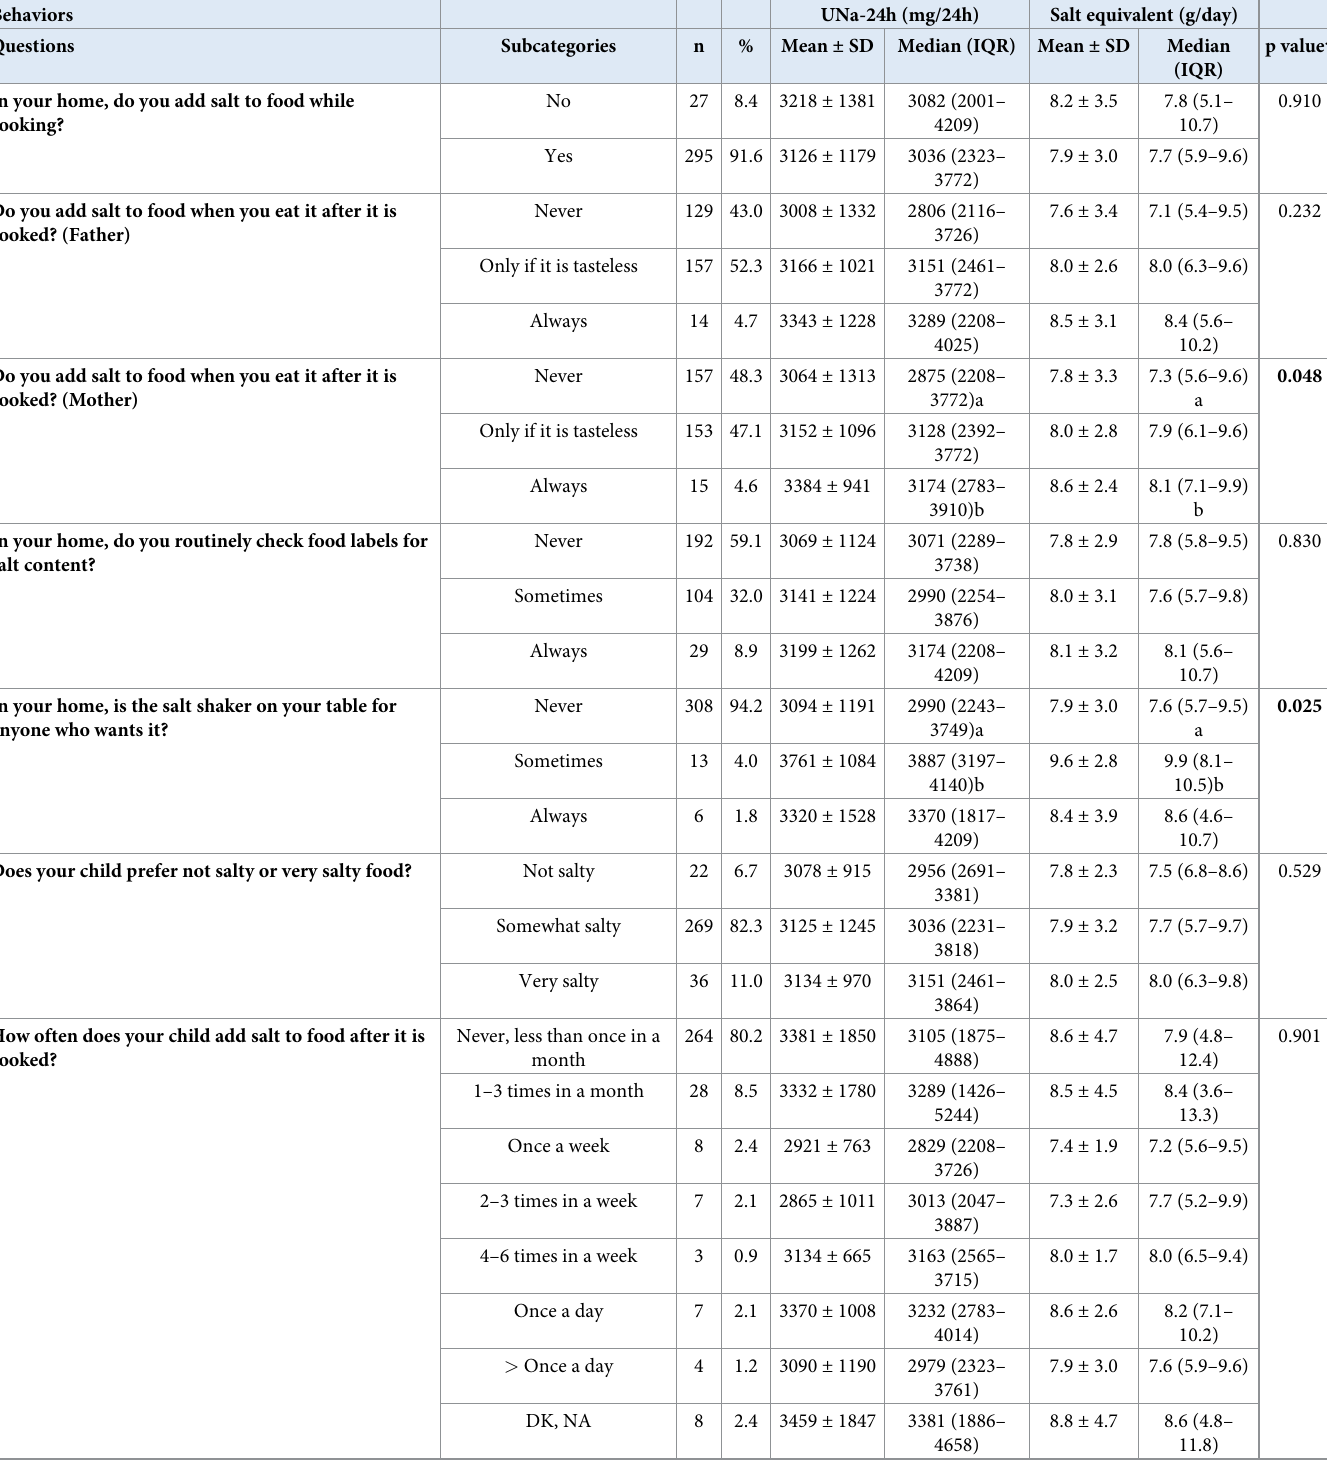
Table 2. Frequency of dietary behaviors related to salt intake and their relationship with sodium excretion (mg/day) in 24-hour urine in Spanish schoolchildren. Behaviors UNa-24h (mg/24h) Salt equivalent